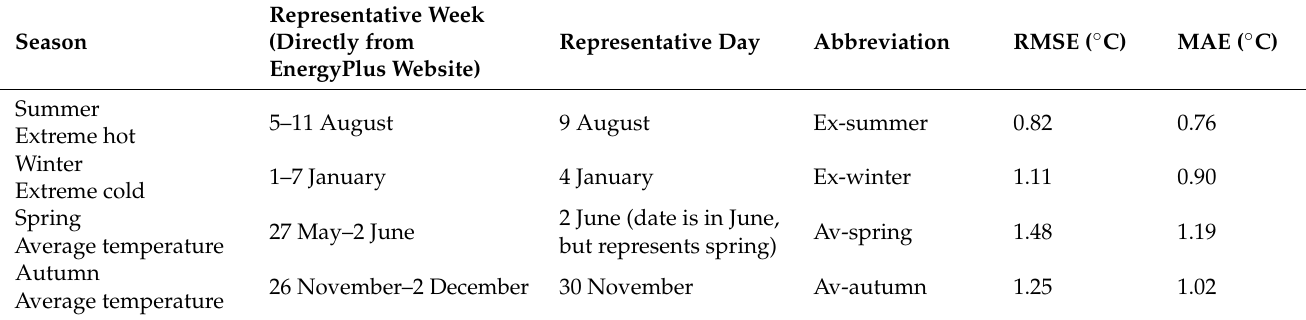
Table 1. Representative days selection of each